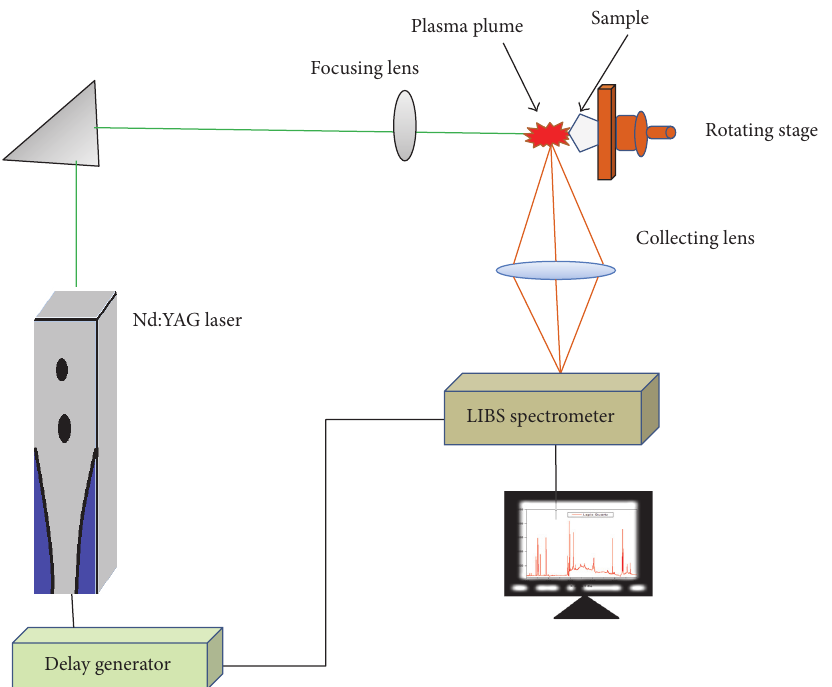
Figure 1: Schematic diagram of LIBS